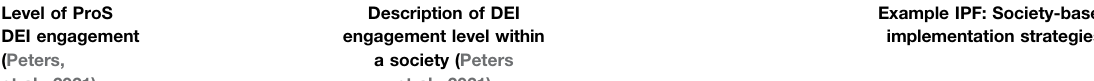
TABLE 2 | Example IPF: Societies implementation strategies within professional